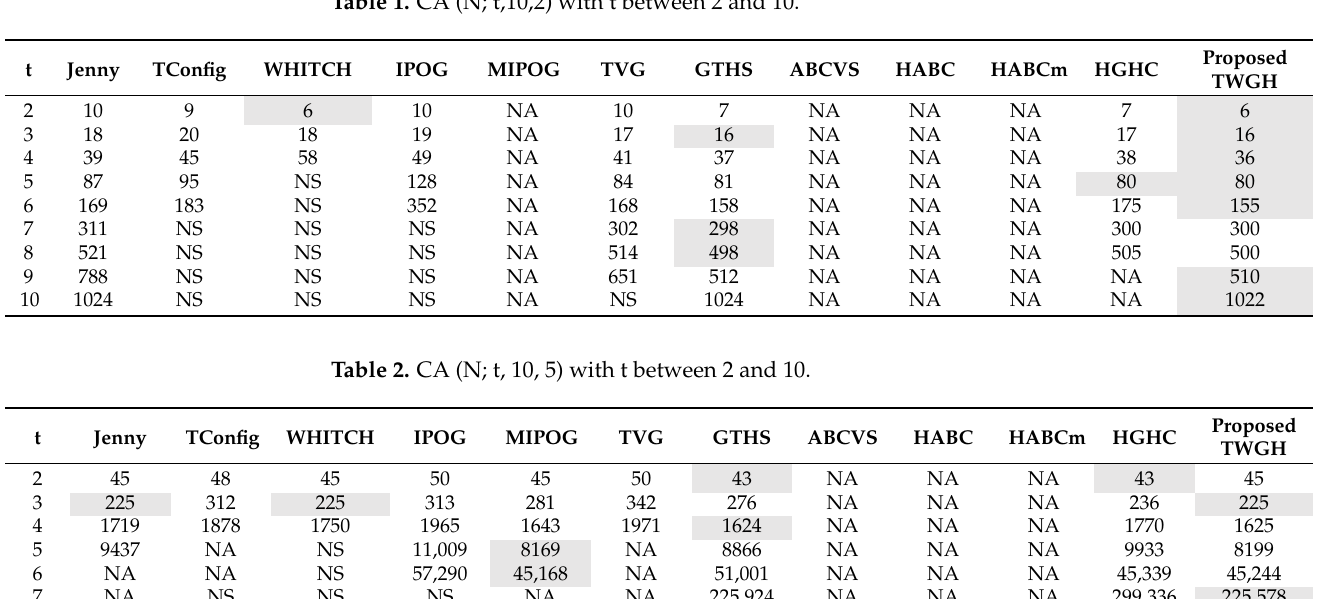
Table 1. CA (N; t,10,2) with t between 2 and 10.